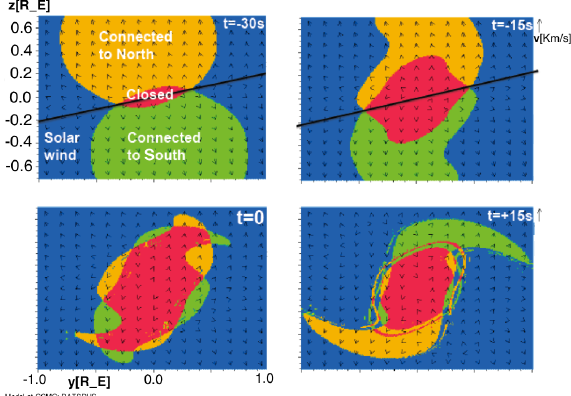
Fig. 9. Magnetic topology for the noon-midnight plane ( x - z plane) for different time instants: t = − 30, − 15, 0, + 15, 120s, considering t = 0 as the time when the magnetic topology changes (interlinked flux tubes onset). Colors are related to the magnetic topology as red, closed; yellow, connected to north; green, connected to south; and blue, solar wind. Arrows indicate flow